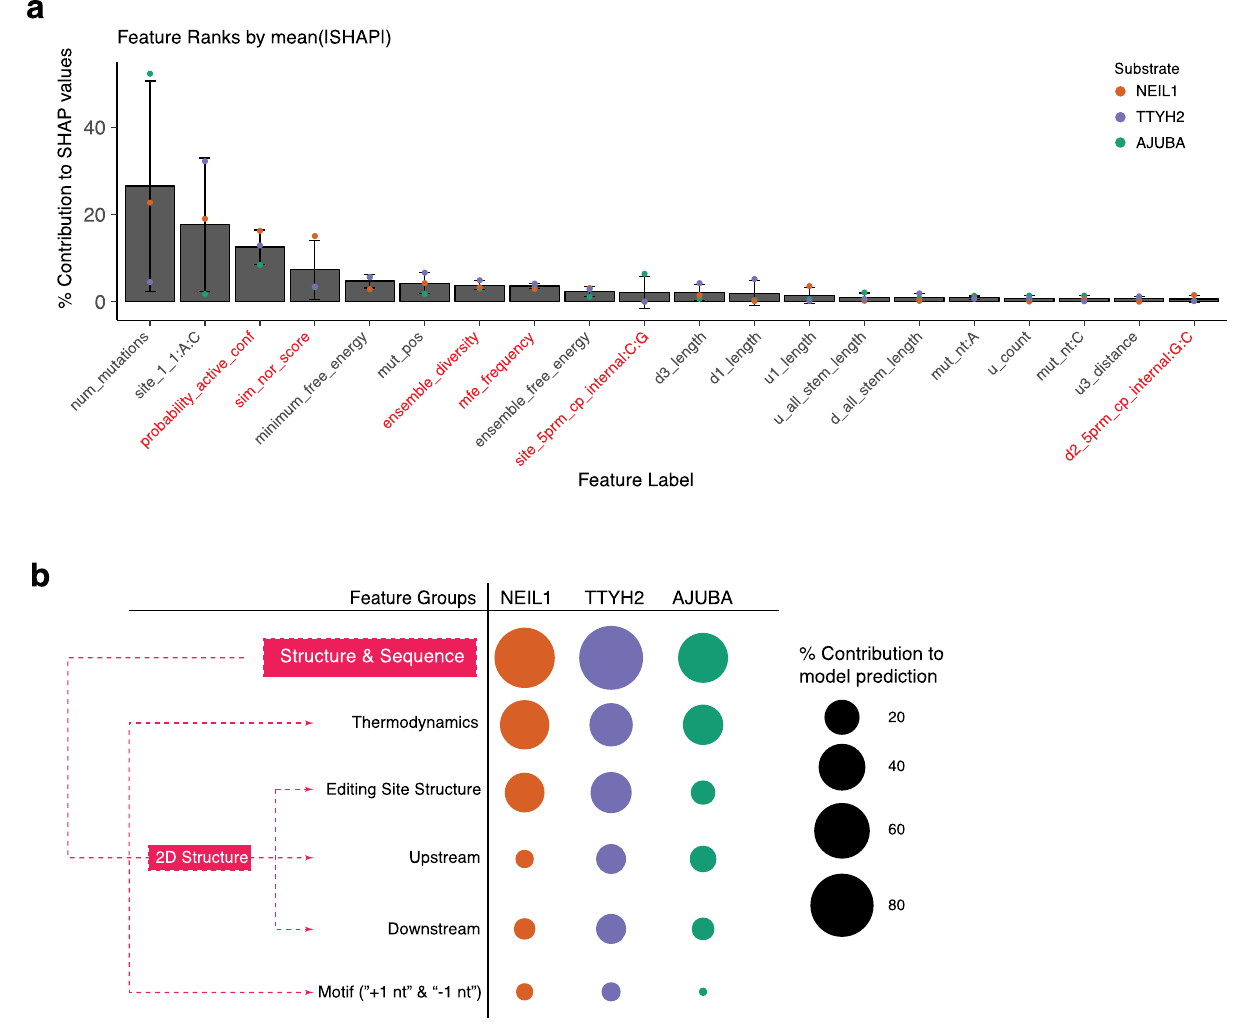
Fig. 8 Cis -regulatory features synergistically contribute to model prediction. a Percent contribution of individual feature to model prediction ranked by averaging normalized SHAP values. Error bars indicate the variability in feature contribution across the three substrates NEIL1 (orange dot), TTYH2 (purple dot), and AJUBA (green dot). The new features unique to this work is highlighted in red. Higher ranking with smaller standard errors indicates that these features are commonly among the highest contributors to model prediction in all three RNAs. b Contributions of different feature groups to the prediction of editing levels for each RNA library. NEIL1 (orange), TTYH2 (purple), and AJUBA (green). Black dots indicate the scale. The subgroups of individual features included in each feature group are listed in Supplementary Data